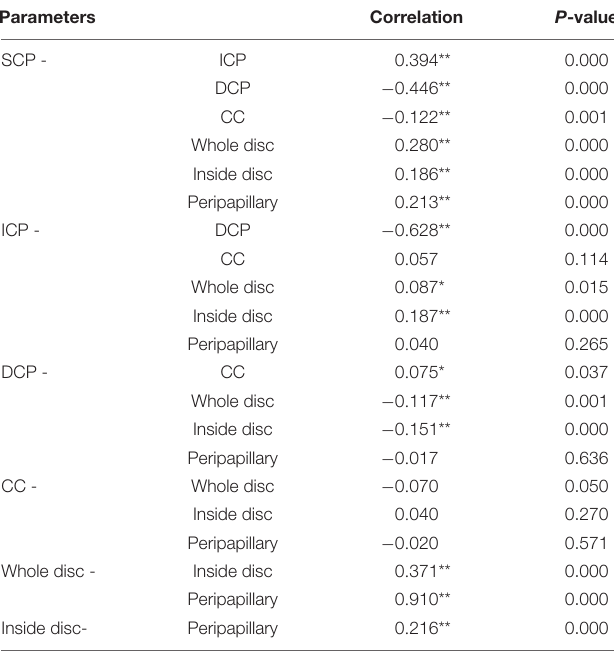
TABLE 3 | Correlations between whole macular VD measured in the different vascular plexuses and disc VD. Parameters Correlation P